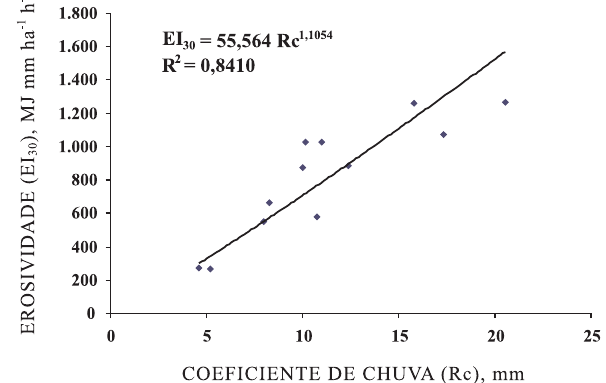
Figura 3. Curva de ajuste potencial entre o índice de médio mensal e o coeficiente erosividade EI 30 de chuva (Rc = Pm 2 /Pa) para São Borja, RS, com base nos valores médios mensais de chuva do período entre 1956 e